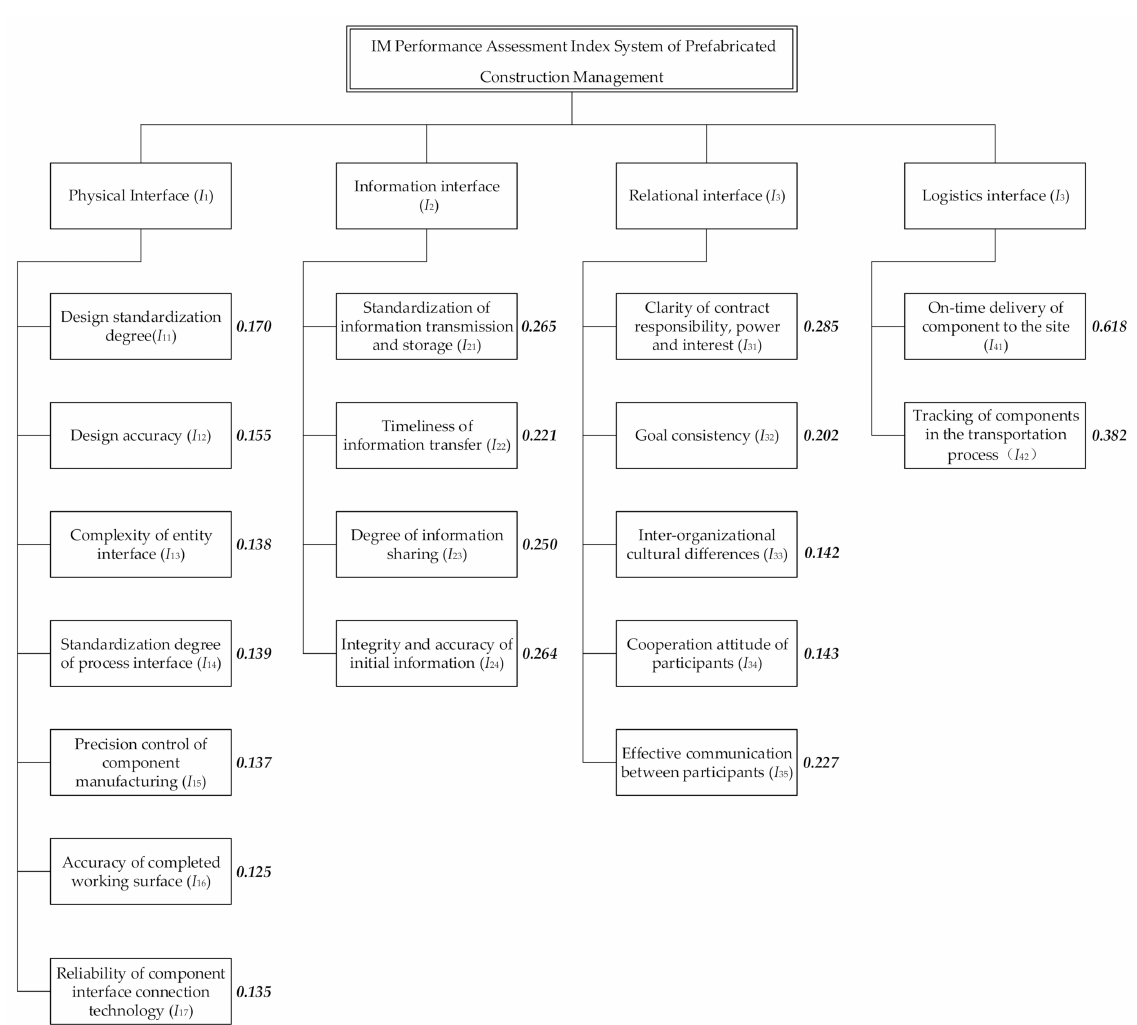
Figure 2. Indicators factors affecting IM performance with local